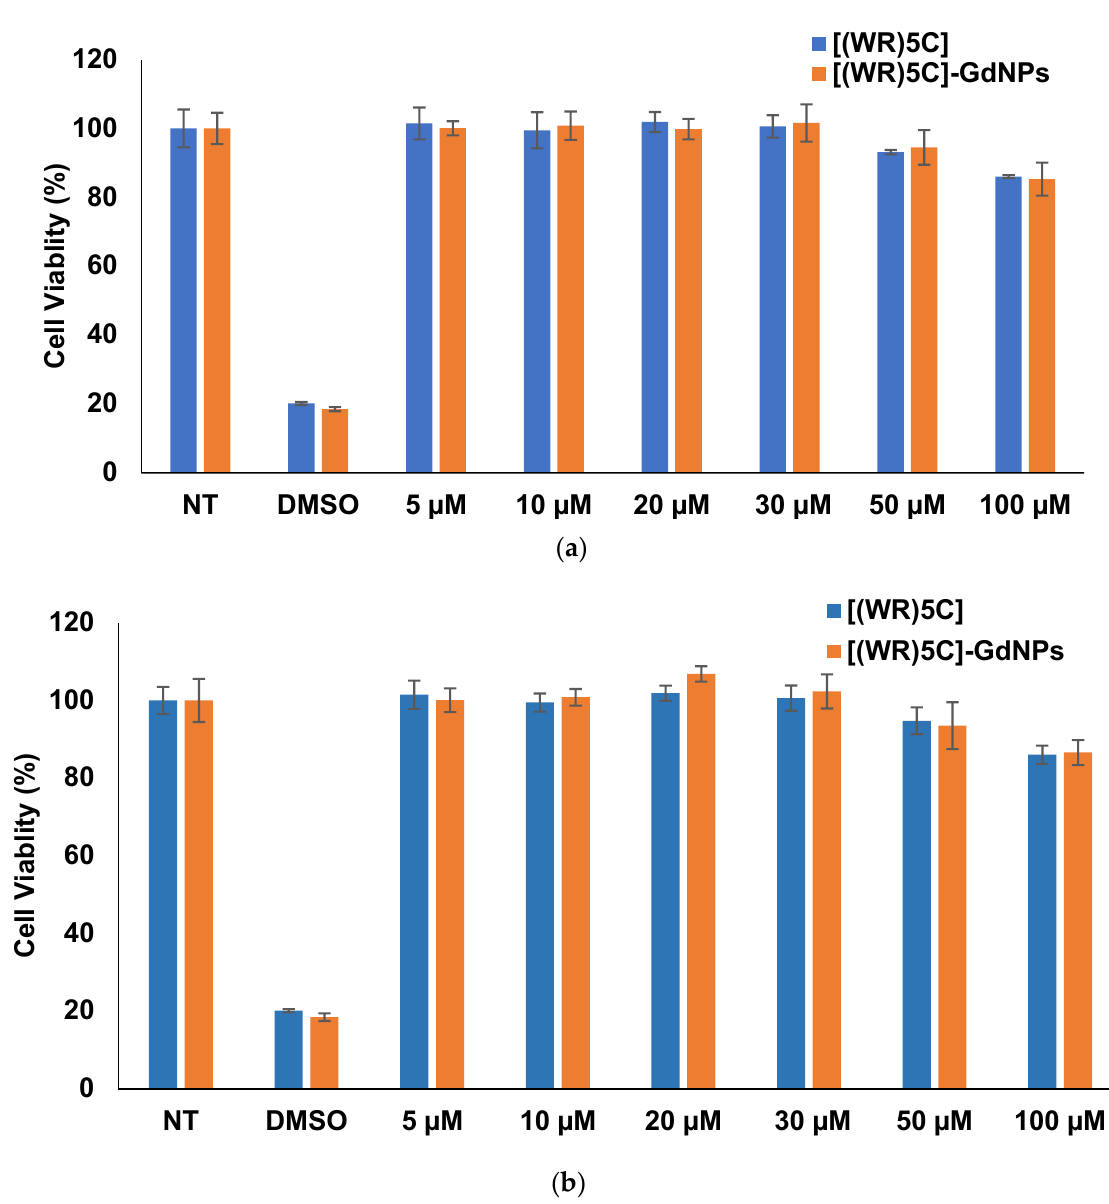
Figure 5. Cytotoxicity of the cyclic peptide [(WR) 5 C] and corresponding [(WR) 5 C]-GdNPs in ( a ) CCRF-CEM cells and ( b ) in MDA-MB-231 cells after 48 h of incubations.